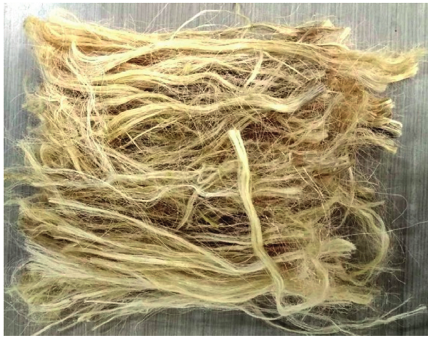
Figure 1: Extracted fiber of Sansevieria ehrenbergii plant.